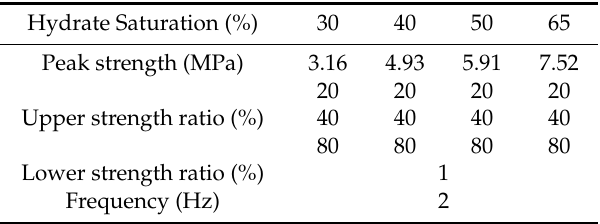
Table 3. Simulation conditions of each group.